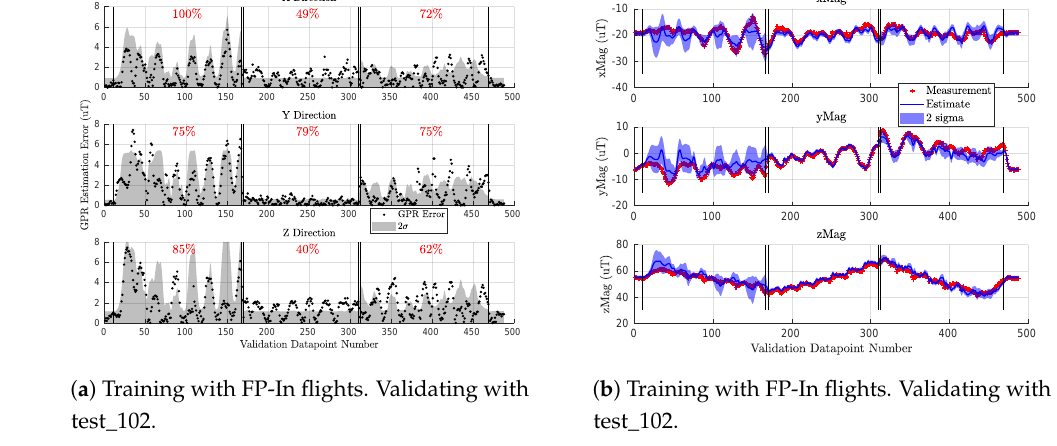
Figure 9. Accuracy of the indoor GPR-based magnetic field map when trained on the five indoor flight profiles (FP-In flights) and validated on test_102 (Scan- β ). The large regions separated by the black vertical lines show areas of constant desired altitude for the Scan- β